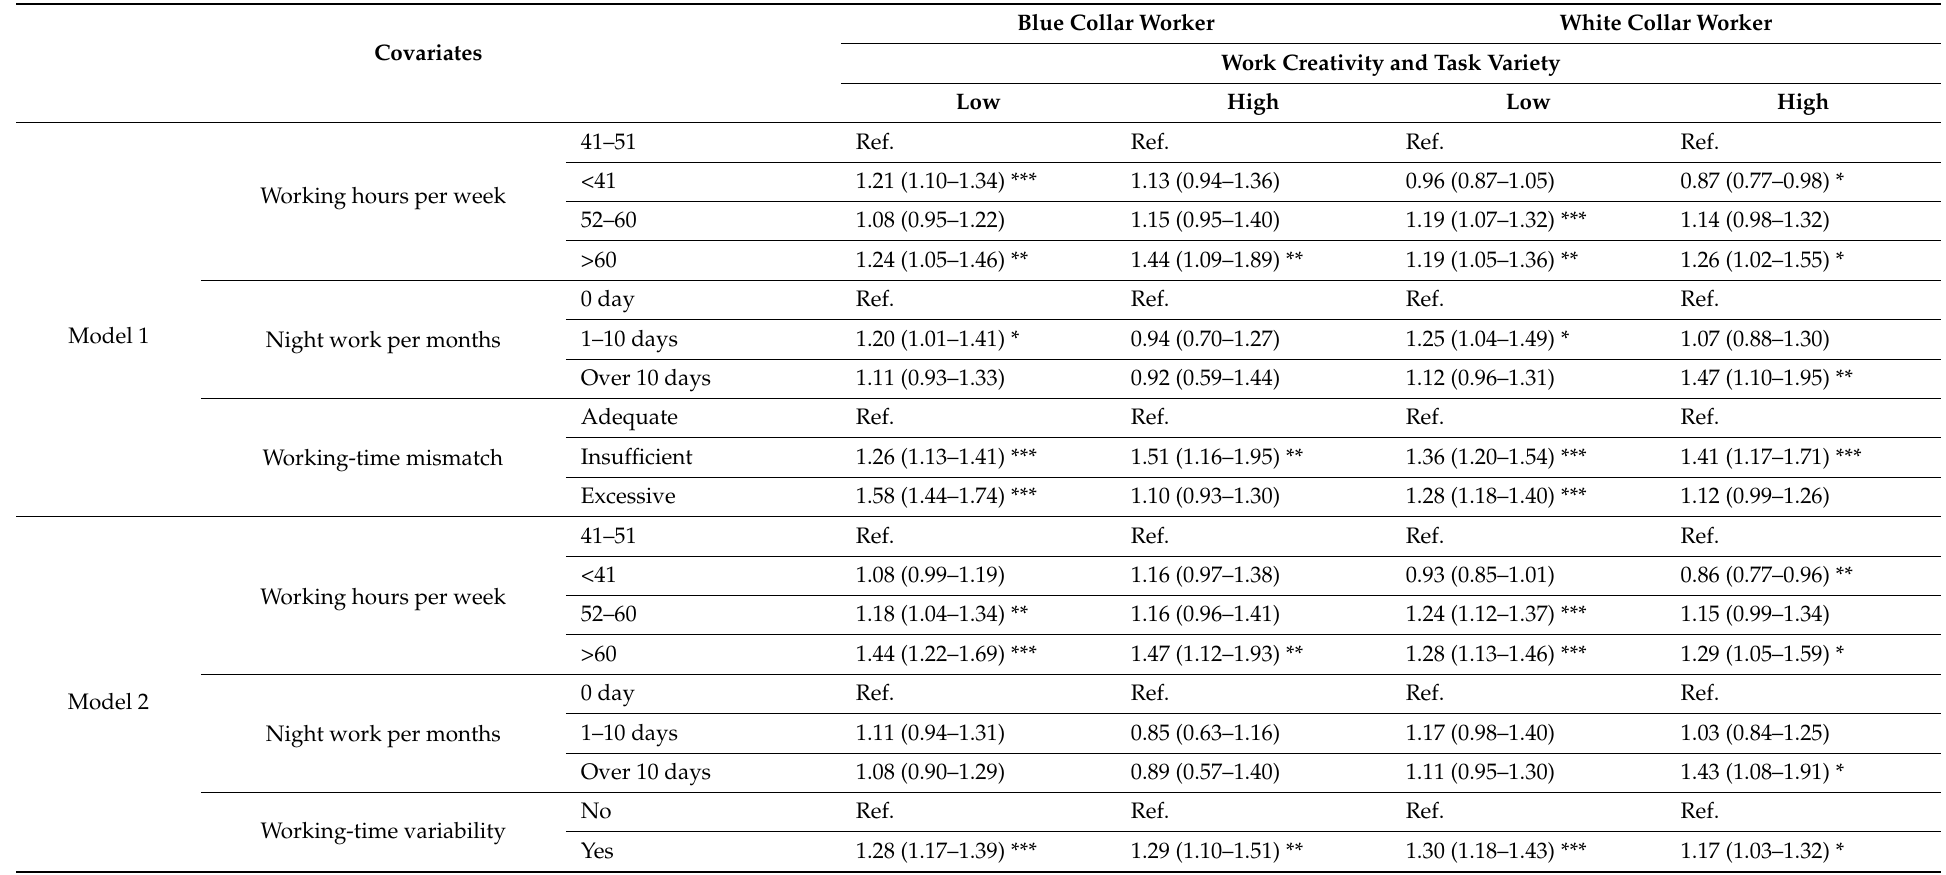
Table 3. Results of multiple logistic regression related to low subjective well-being according to work creativity and task variety and occupation after adjusting for working-time mismatch, variability, shift work, and autonomy. Odds ratio (95% Confidence